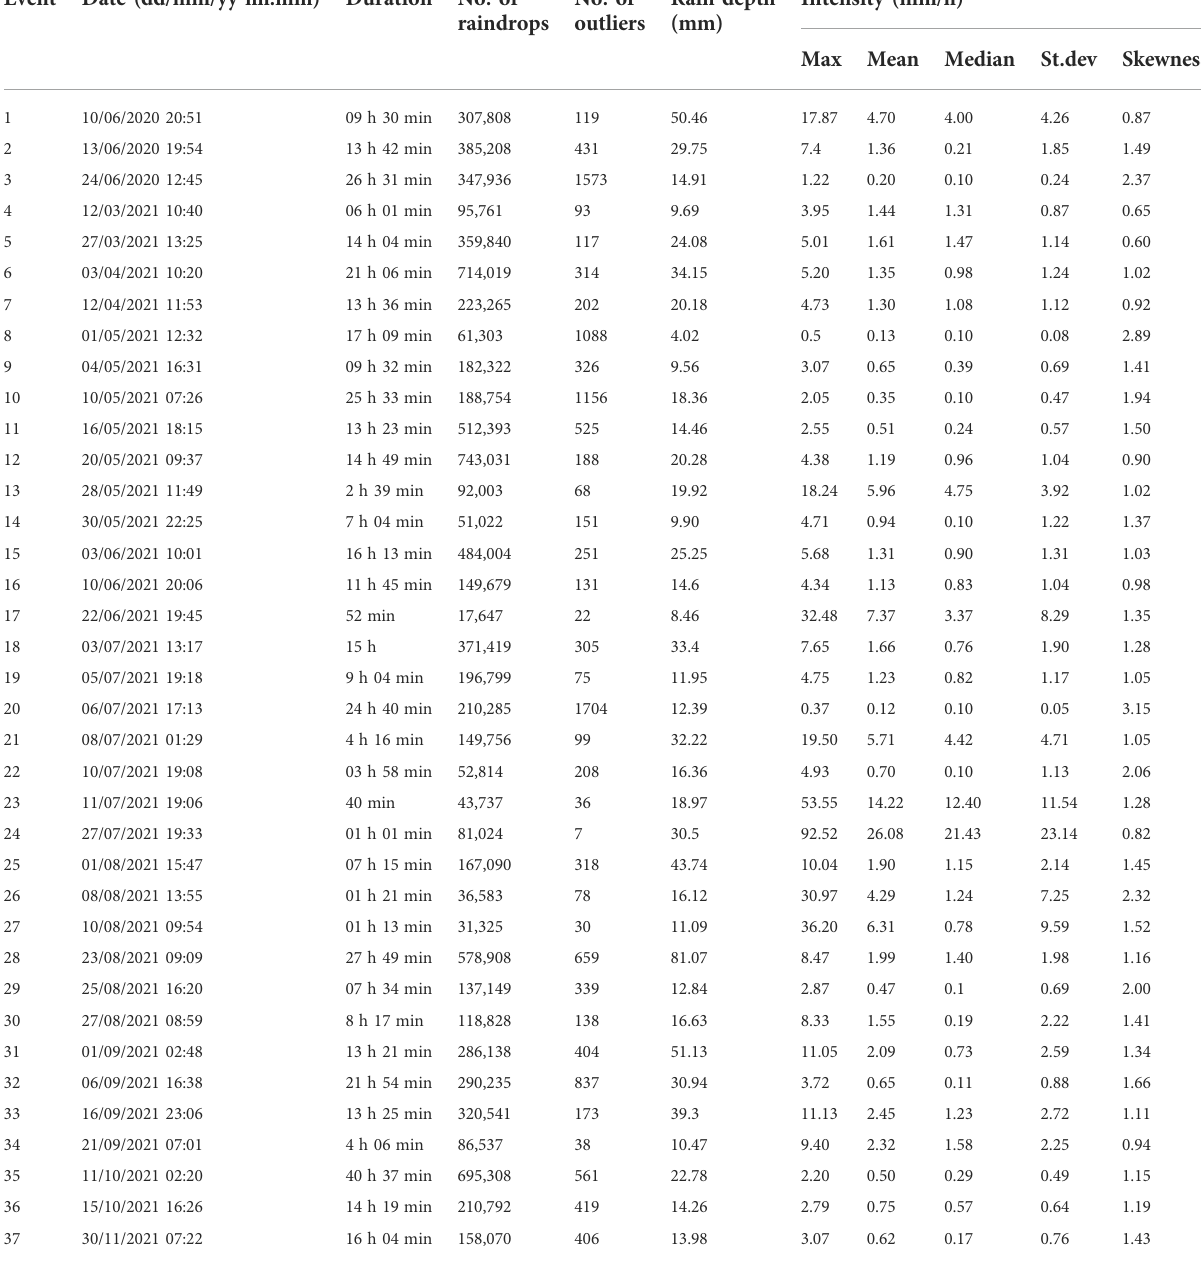
TABLE 1 Statistical information on the selected rainfall